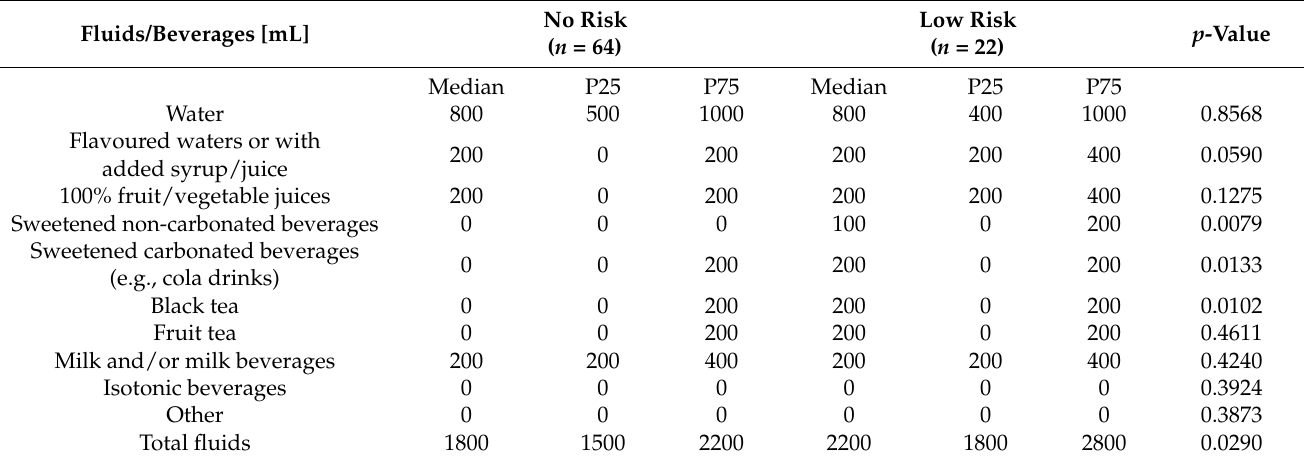
Table 5. Declared amount of drinks consumed [ml] per day in relation to the assessment of the severity of erosive tooth wear according to BEWE for the total